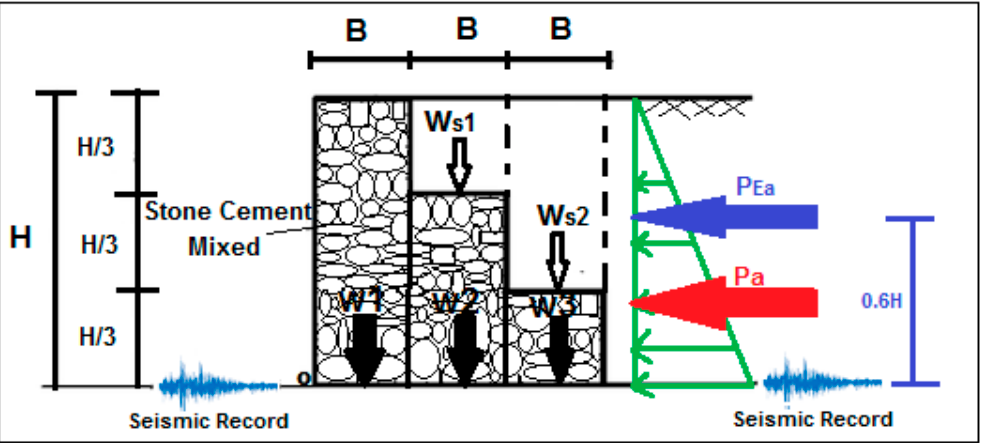
Figure 5. Distribution of active force for static and dynamic conditions with body forces for soil and Stone blocks. Table 1. General description of the used database.